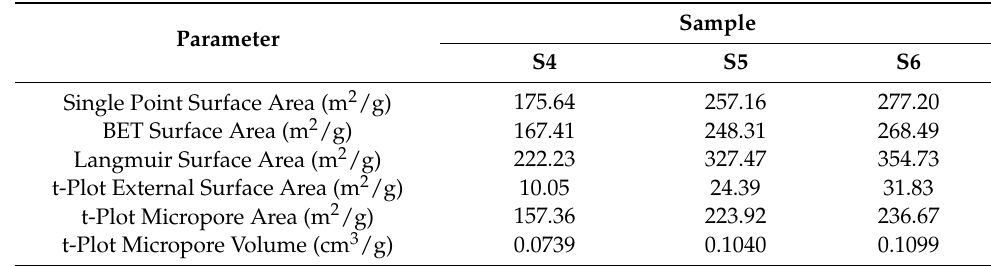
Figure 7. ( a – c ) Pore area of the porous silicon oxycarbide materials. Table 4. Surface area and pore volume data for samples